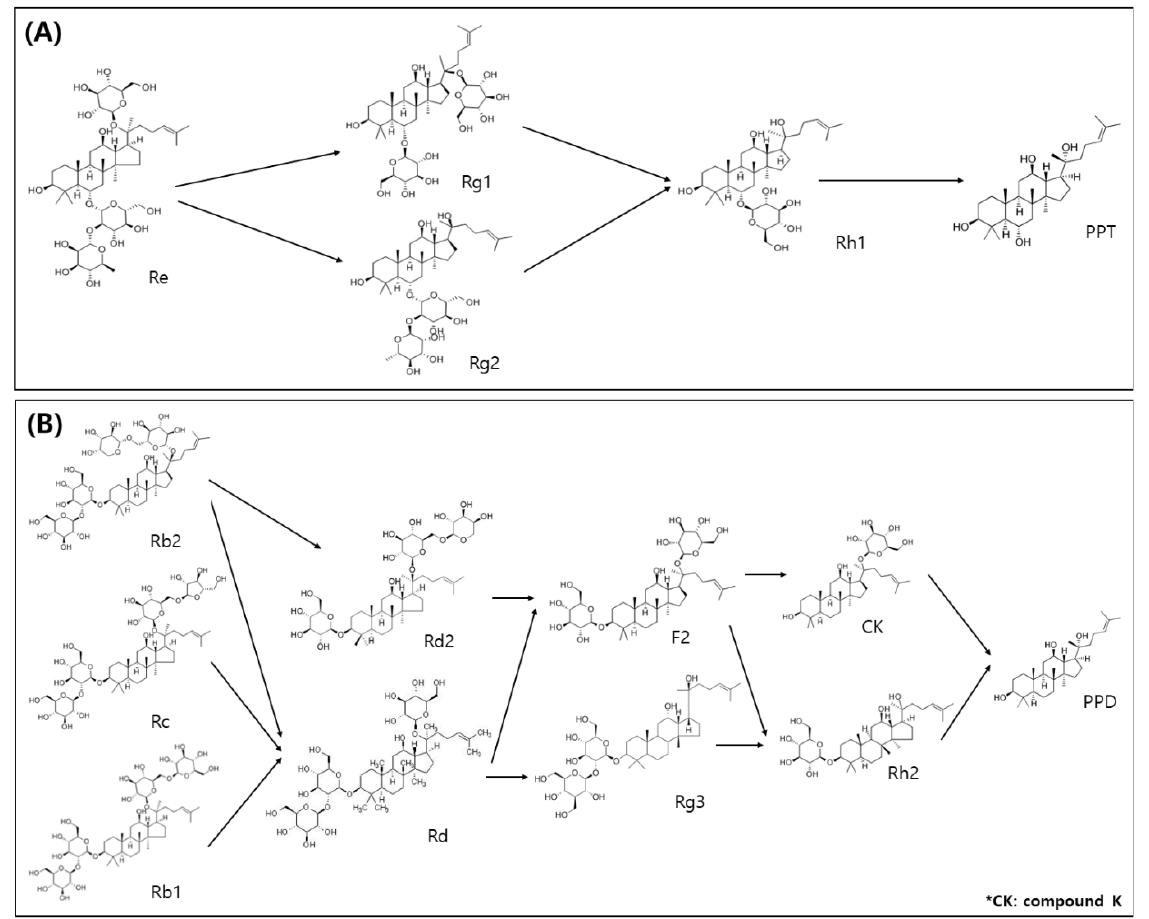
Figure 5. Bioconversion pathway of ginsenoside compositions in mountain-cultivated ginseng sprouts during the processing steps. ( A ) Pathway of protopanaxatriol (PPT) type; and ( B ) Pathway of protopanaxadiol (PPD) type.